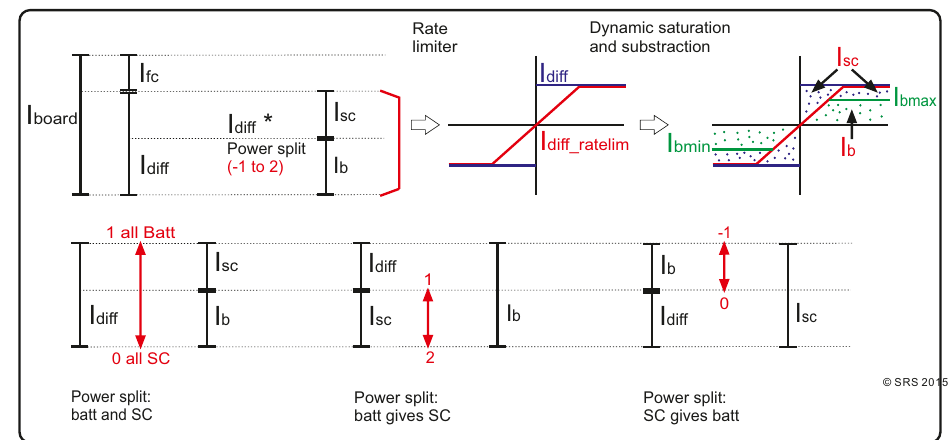
Figure 19. Working of the PM controller